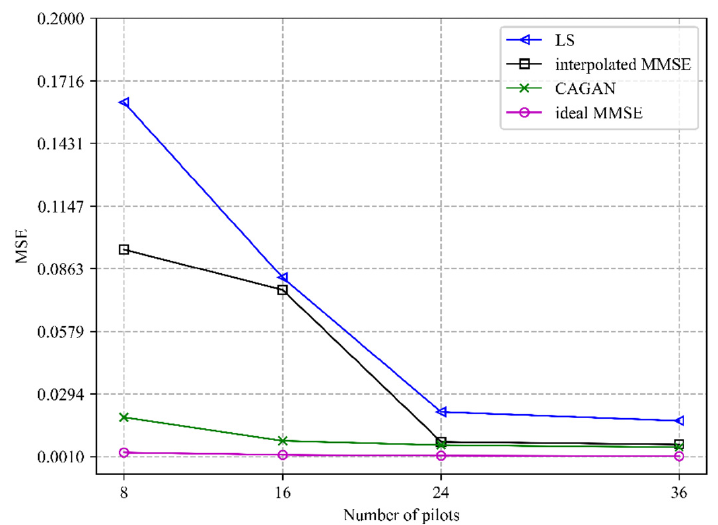
Figure 3. Comparison of channel estimation performance of different algorithms under different pilot numbers when SNR = 15